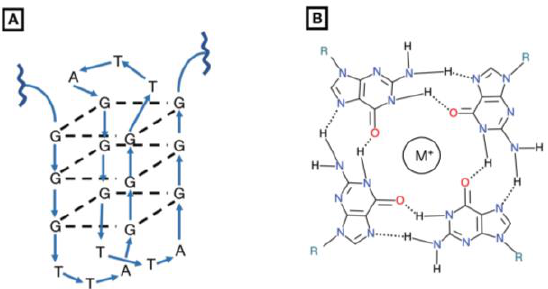
Figure 2. Structure of G-quartet inhibitor. ( A ) The G-quartet oligodeoxynucleotide is comprised of four guanosine macrocycles stacked on top of one another. To date, they have been used as competitive inhibitors of HIV-1 integrase but have demonstrated potential STAT3 dimerization inhibitors. With i.p. and i.v. injection in vivo mouse xenografts, G-quartets have been shown to reduce tumor growth in breast, prostate, and non-small cell lung cancers [85–87]. ( B ) An overhead view of a G-macrocycle demonstrates how hydrogen bonding generates a tetrad-helical structure with a monovalent cation at its core.